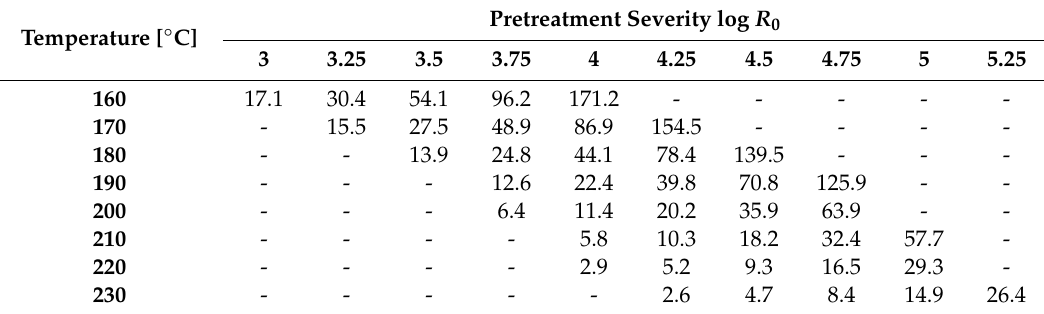
Table 1. Summary of the tested pretreatment conditions. Shown are the pretreatment durations in [min] to reach the targeted severities log R 0 (see Equation (1)) at a given temperature. Temperature [ ◦